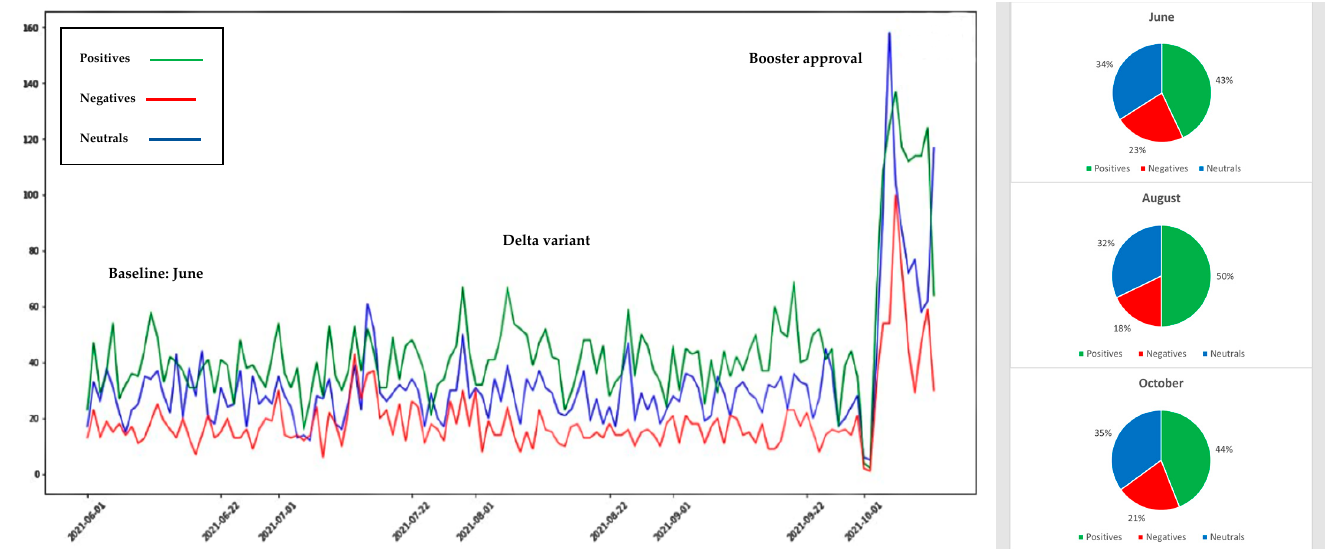
Figure 5. Sentiment analysis results of tweets related to Johnson and Johnson vaccine.